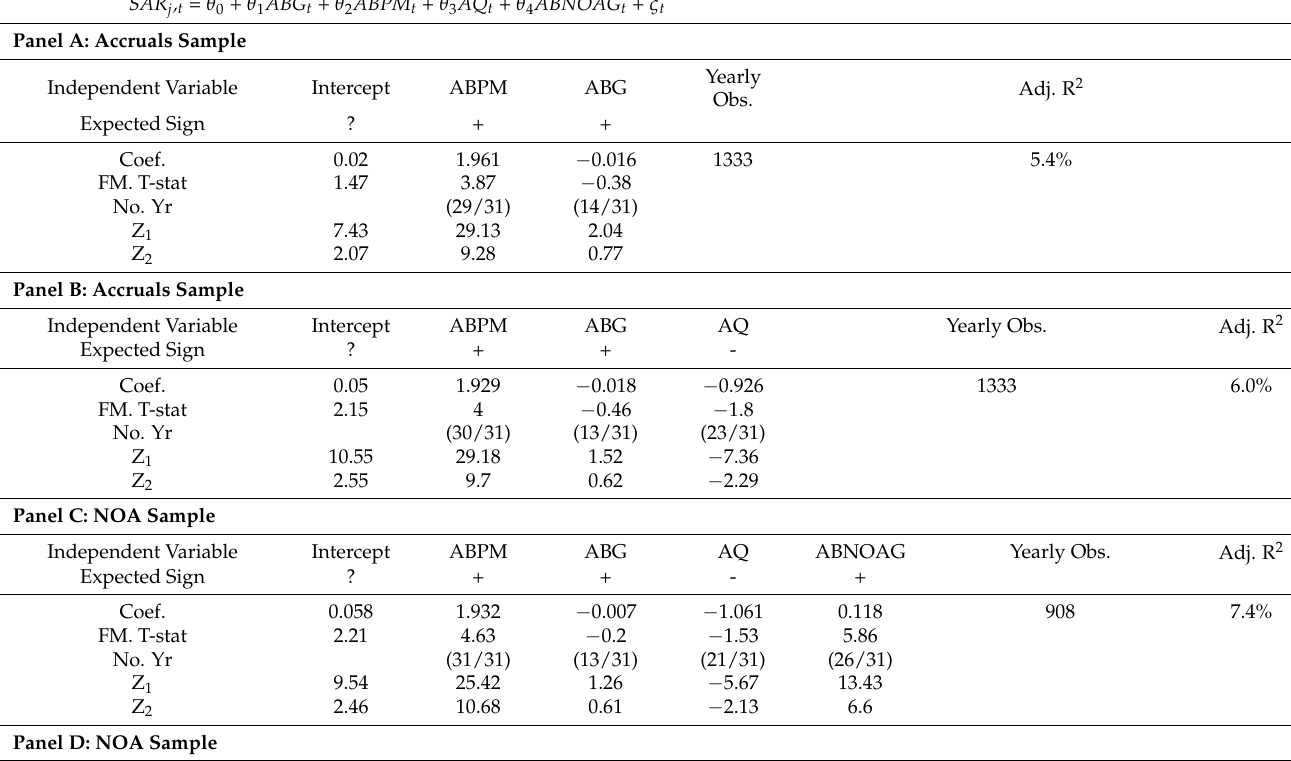
Table 6. Results of the regression of one-year-ahead decile size-adjusted